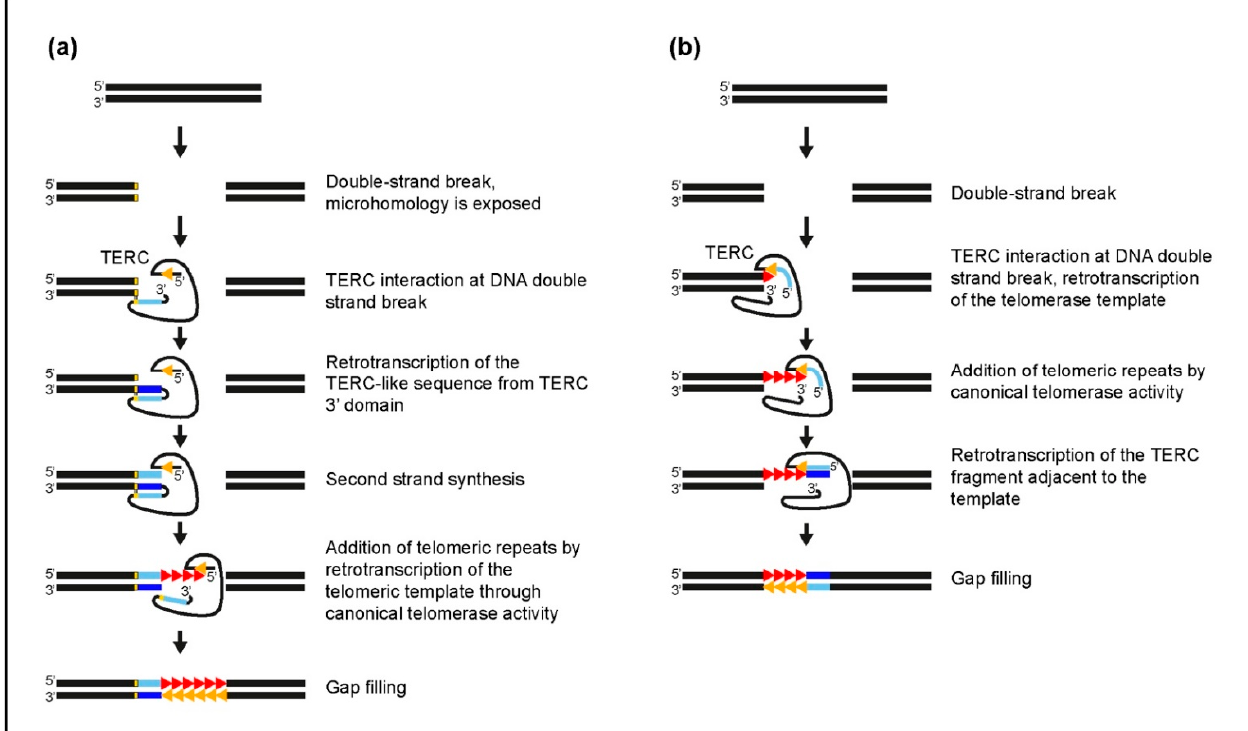
Figure 5. Models explaining the insertion of TERC-ITSs at break sites. ( a ) Insertion of a TERC-ITS containing a TERC-like fragment and a telomeric repeat array in an opposite orientation. This model (modified from [34]) describes the origin of TERC-ITSs containing sequences homologous to the 3 ′ end of TERC. After a double-strand break, TERC interacts with one side of the break exposing its 3 ′ domain. Microhomologies (yellow lines) may favor the interaction. The 3 ′ end of telomerase RNA may then fold back, acting as a primer for retrotranscription of the scaRNA domain (the dark blue line represents the sequence retrotranscribed from the 3 ′ domain of TERC). The sequence retrotranscribed from the 3 ′ domain of TERC is used as a template to synthesize the second DNA strand (light blue line). This step is followed by retrotranscription of TTAGGG repeats (red triangles) from the telomeric repeat template (orange triangle) through the canonical telomerase enzyme activity. ( b ) Mechanism proposed for the insertion of loci in which the TERC fragment and the telomeric repeats are in the same orientation. Telomeric repeats are retrotranscribed by telomerase using a 3 ′ end of the DNA break site as a primer. The addition of the last telomeric repeat is followed by the retrotranscription of an adjacent portion of the TERC RNA.